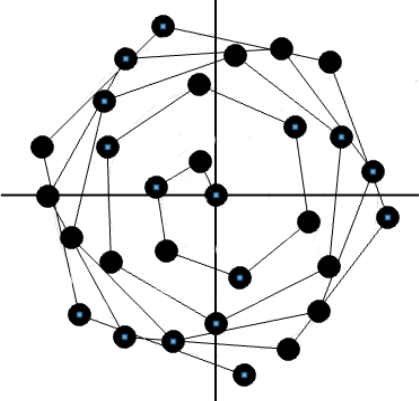
Fig. 2. The graph of a sequence of discrete values of the natural logarithm ln (n) in a polar coordinat system for n = 1, 2,…,